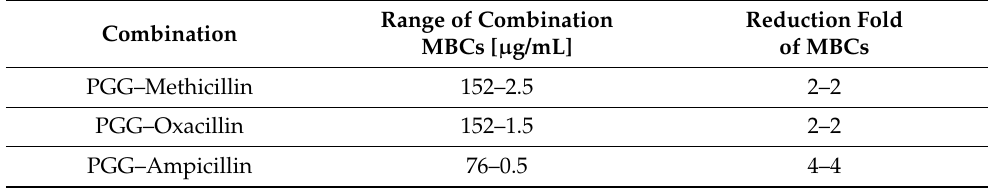
Table 3. Antibacterial effect (MBC) of PGG combined with antibiotics.